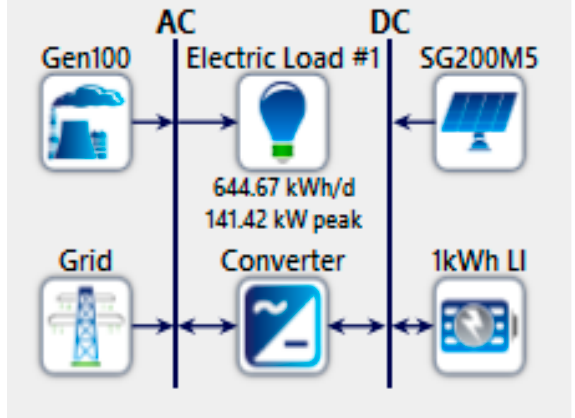
Figure 4. Microgrid structure with available resources at MUST site.